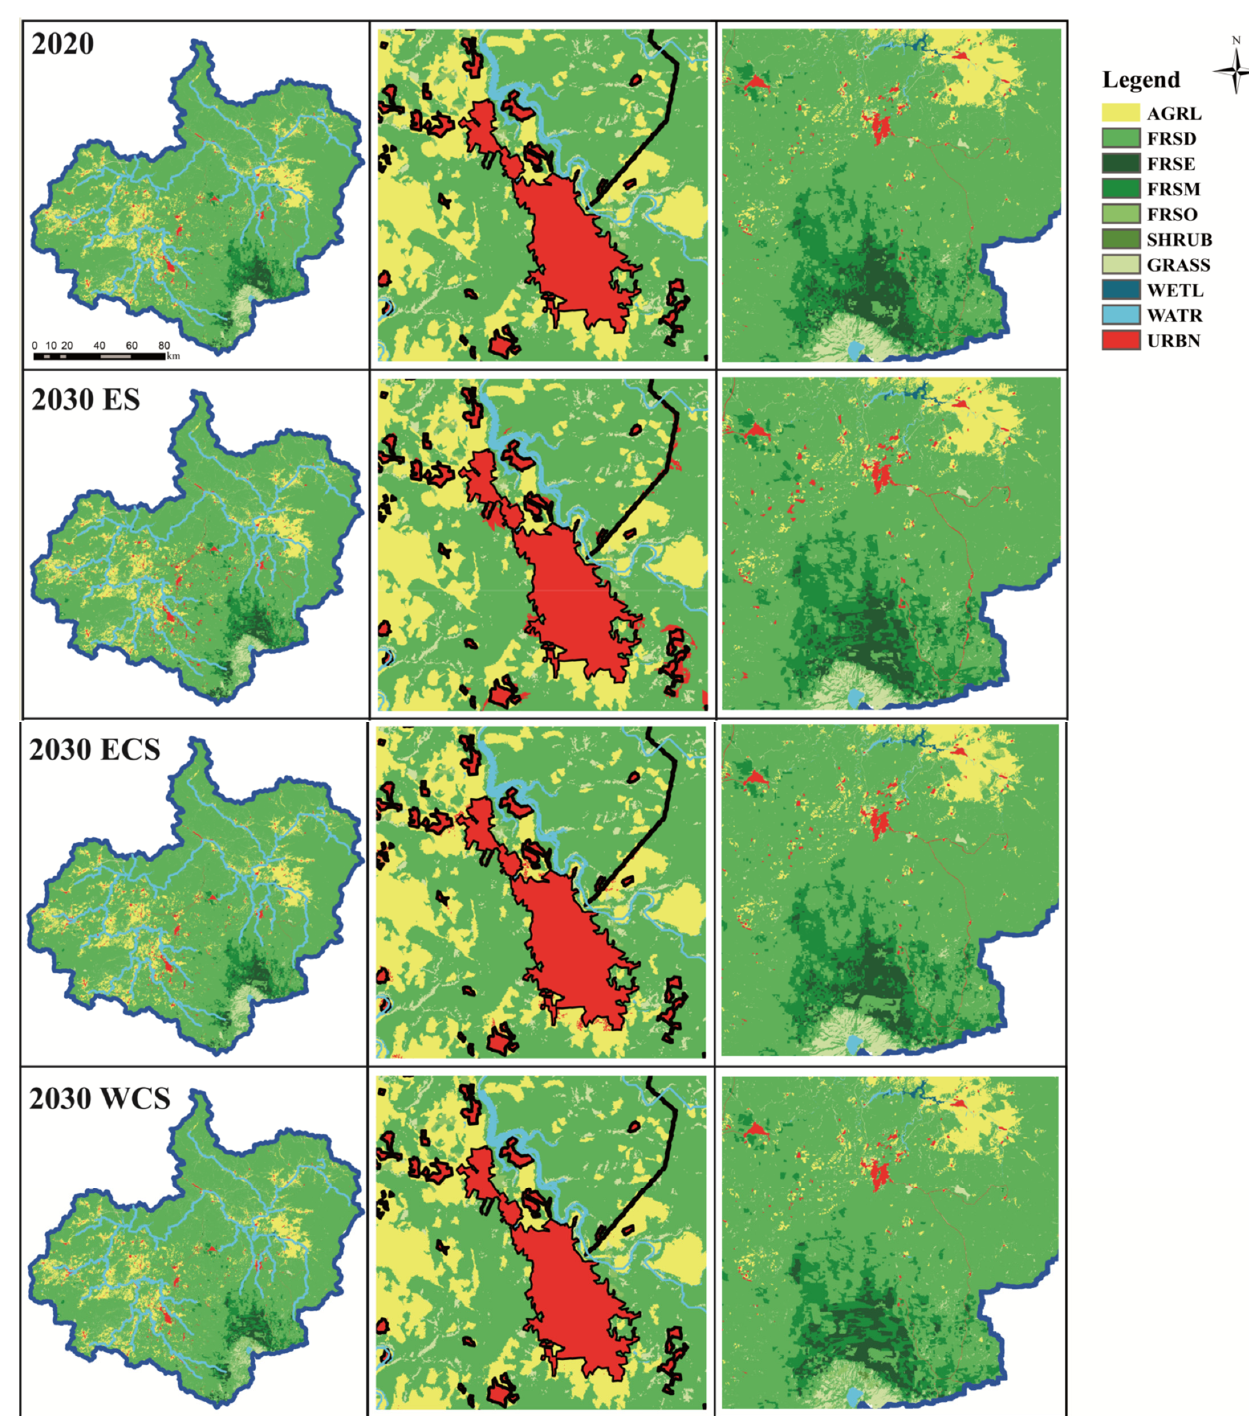
Figure 6. Land use planning maps of the three scenarios in 2030: the first column is land use map, the second column is the magnification of Fusong County, and the third column is the magnification of Changbai Mountain area. Each land use name code is the same as in Table 1.